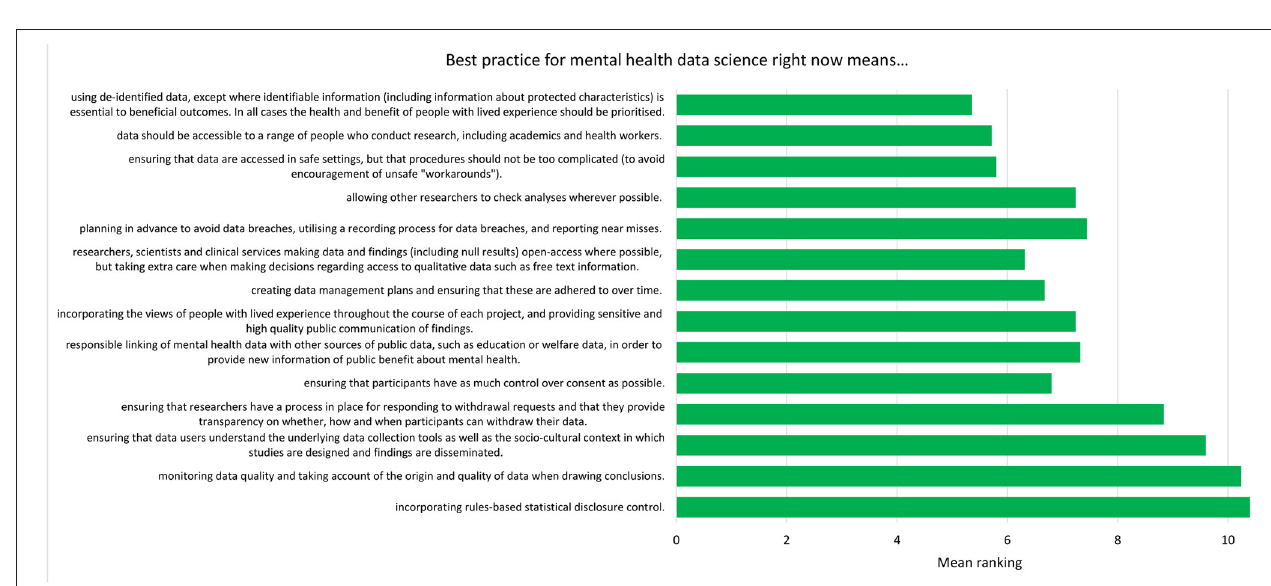
FIGURE 2 | Mean ranking of statements in the current best practice checklist during Phase 2, ordered by median ranking. Lower scores (at the top of the figure) indicate higher importance (number of participants = 25).